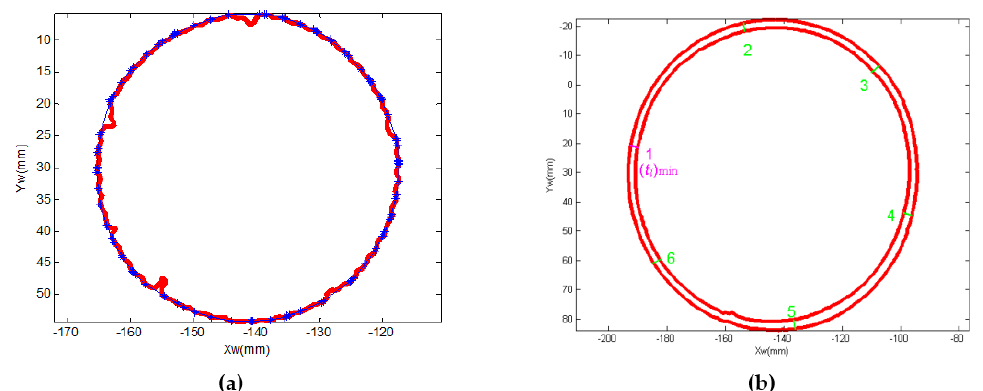
Figure 10. Cross-section measurement. (a) Perimeter measurement, in which red dots are contour 𝐶 𝑘 and blue asterisks are vertexes of convex hull; (b) Thickness measurement, in which magenta line is minimum thickness and green lines are the other five thickness measurements clockwise.